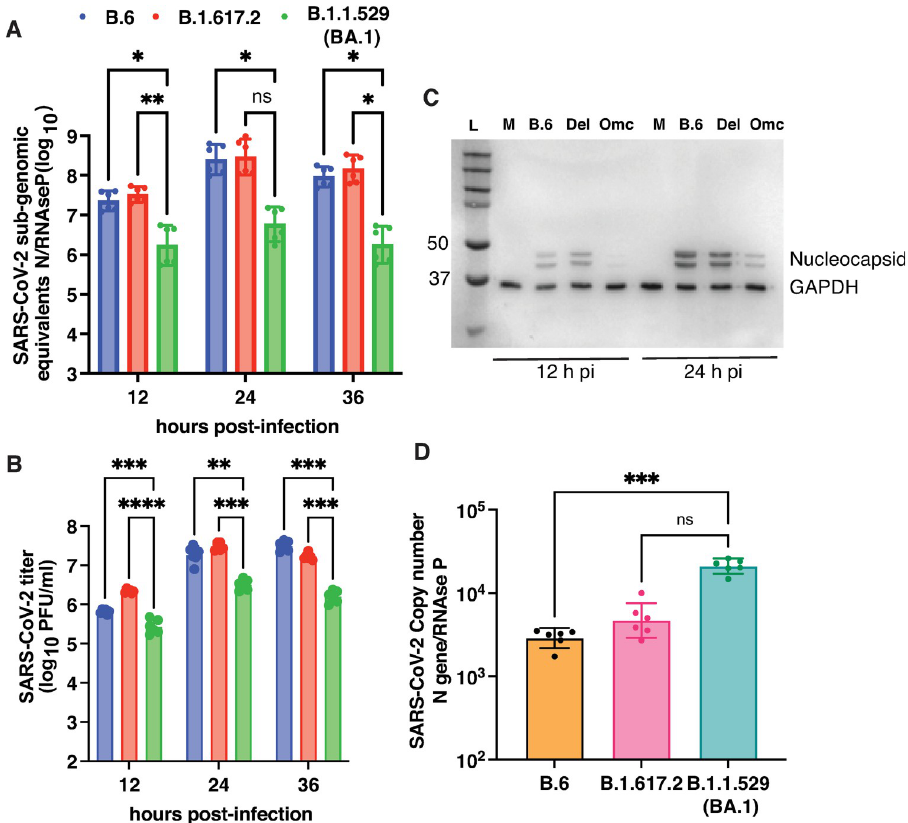
Fig 3. Growth kinetics of B6, B.1.617.2, and B.1.1.529 variants in Calu-3 cells. (A) Calu-3 cells were infected with above variants of SARS-CoV-2 at 0.3 MOI. Cells were collected at indicated time points and total RNA was isolated to estimate N gene copy numbers by RT-qPCR. RNase P was used as a housekeeping control for normalization. Error bars represent geometric mean with 95% CI. (B) Viral titers were measured in supernatants by plaque assay. Error bars represent geometric mean with 95% CI. Statistical significance was estimated by two-way ANOVA with Dunnett’s multiple comparisons test. (C) Western blot analysis of cell lysates prepared from infected cells at indicated time points to detect the expression of SARS-CoV-2 nucleocapsid. Glyceraldehyde 3-phosphate dehydrogenase (GAPDH) was used as a loading control. Numbers on the left indicate the size of the bands in molecular weight marker. (D) Calu-3 cells were infected at 5 MOI and the amount of internalized RNA was estimated by RT-qPCR as described above. Data are from two independent experiments. Error bars represent geometric mean with 95% CI. Statistical significance was estimated by Kruskal-Wallis test with Dunn’s multiple comparison test. ns: non-significant, � P < 0.05, �� P < 0.01, ��� P < 0.001, ���� P <